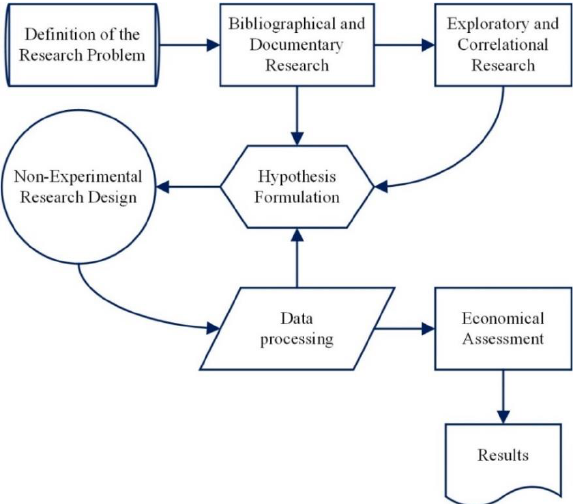
Figure 1. Methodology